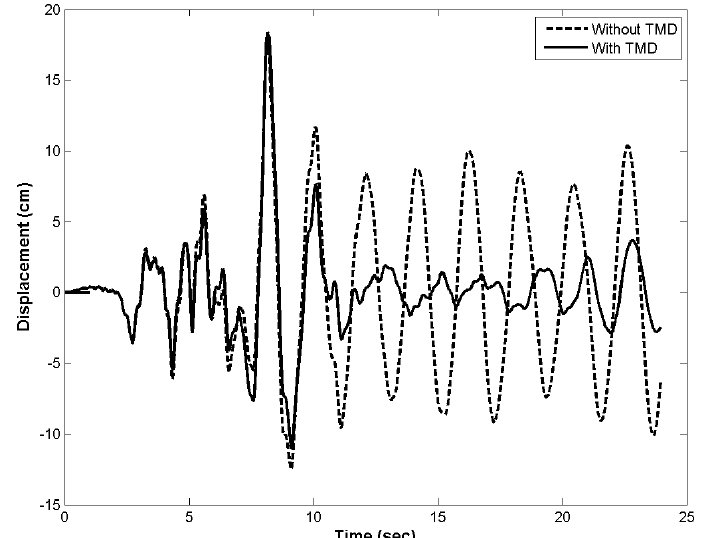
Fig. 6. Displacement Results for the Roof of a First Floor Irregular Structure Subjected to the Northridge Earthquake (PGA = 0.1g)